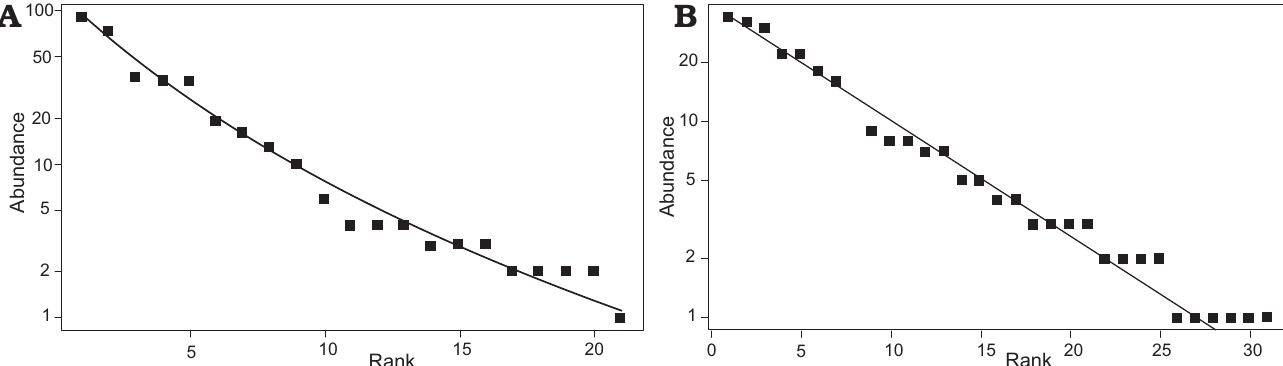
Fig. 11. Rank-abundance distribution of bulk samples ( A ) and museum collection (Whittaker plots) ( B ). Y axis shows species abundance; X axis ranks each species in order from most to least abundant. Black dots represent species.